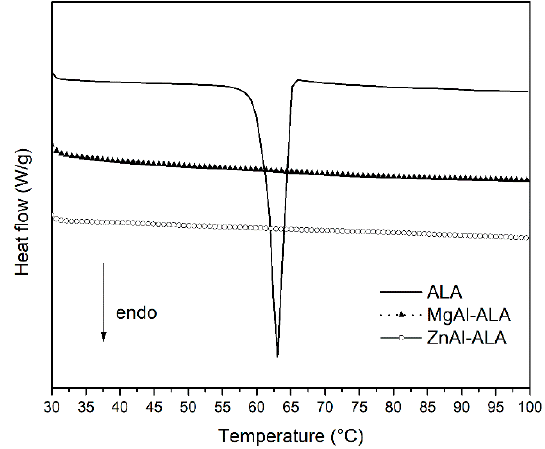
Figure 1. Thermograms registered by differential scanning calorimetry analysis of free crystalline ALA, MgAl-ALA, and ZnAl-ALA.